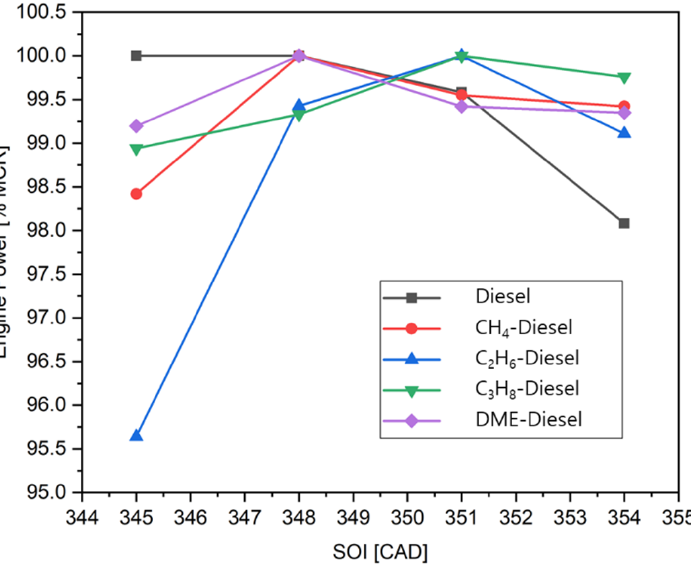
Figure 26. Synthetic of engine power according to pilot SOI angles in all combustion modes